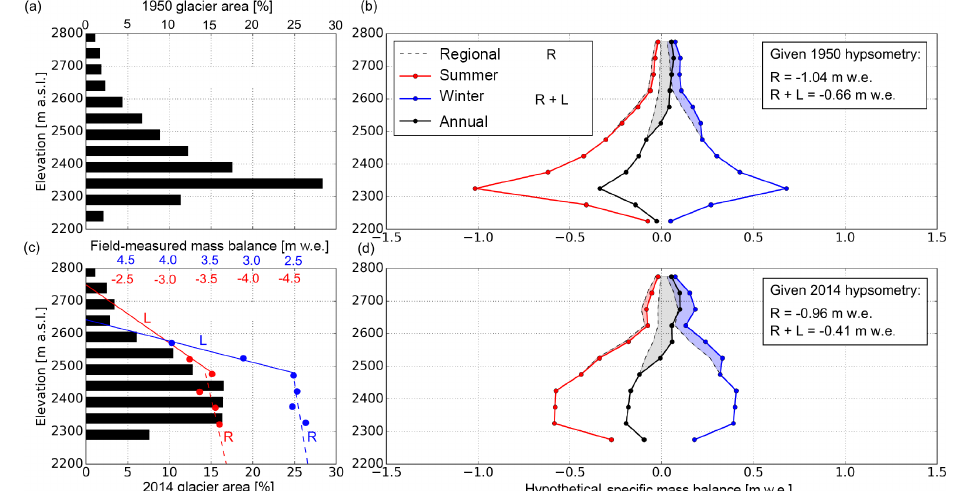
Figure 7. Parsing local from regional mass balance drivers. (a) Hypsometry of the 1950 glacier, presented in 50m elevation bands (black bars). (b) Sperry Glacier hypothetical mass balance, as it varies with elevation, given 1950 glacier hypsometry and mass balance gradients. Solid lines show the summer (red), winter (blue), and annual (black) balances calculated using field-measured local (L) and regional (R) mass balance gradients shown in (c) . Dotted black lines show the same but excluding L at high elevations, i.e., using R only. (c) Hypsometry of the 2014 glacier surface (black bars), and mass balance gradients measured at Sperry Glacier (red and blue dots and lines). The means of 2005–2014 summer (red dots) and winter (blue dots) point mass balances, measured at stakes sites, are plotted against the average elevation of the 50m elevation band wherein the stake was located. Lower-elevation ( < 2475m) mass balance gradients reflect regional (R) mass balance gradients for melt (dashed red line) and snow water equivalent (SWE) (dashed blue line). Higher-elevation ( > 2475m) mass balance gradients reflect local (L) mass balance gradients for melt (dotted red line) and SWE (dotted blue line). (d) Sperry Glacier hypothetical mass balance as shown in (b) , but given 2014 glacier